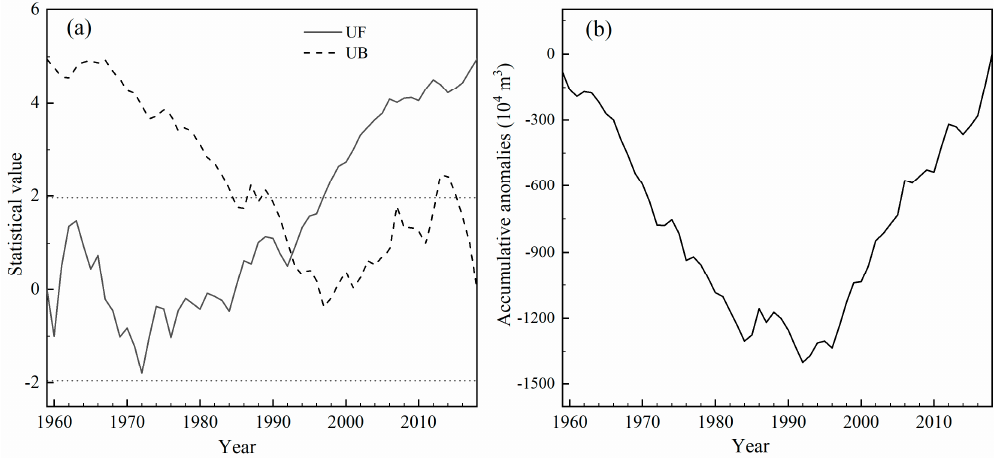
Figure 7. Curves of the Mann–Kendall mutation test ( a ) and cumulative anomaly ( b ) of glacial runoff of the Urumqi Glacier No. 1.